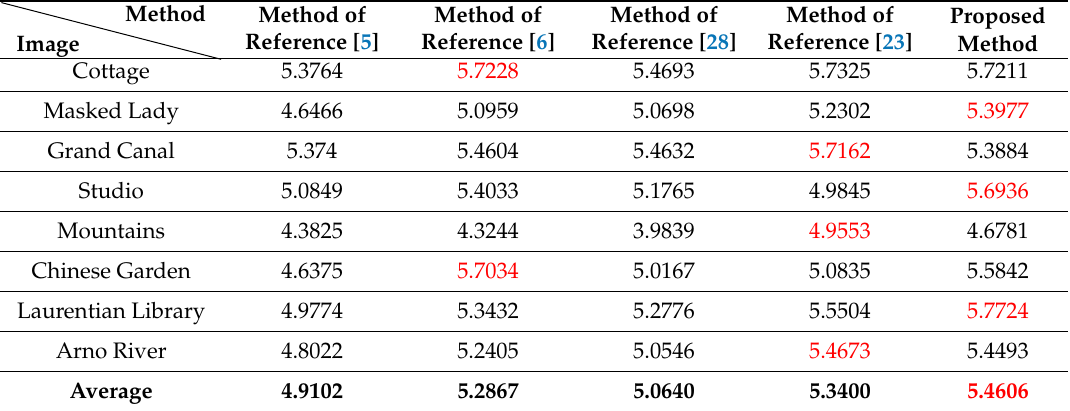
Table 6. Comparison of the five methods in terms of NIQMC